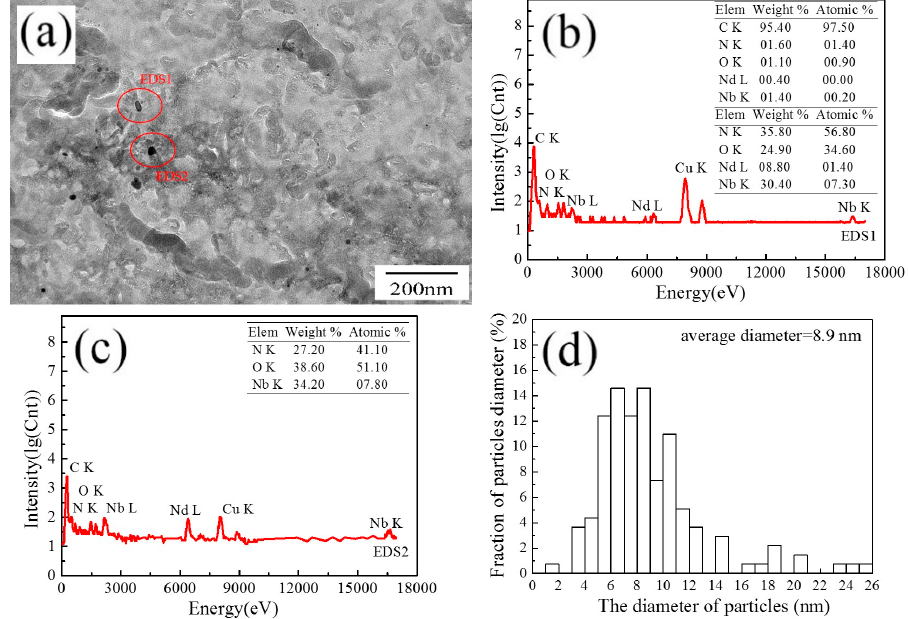
Figure 17. TEM images of the precipitation and EDS of the 22Mn3SiNb steel. ( a ) TEM images of precipitation particles, ( b , c ) precipitation particles for EDS, ( d ) size distribution.